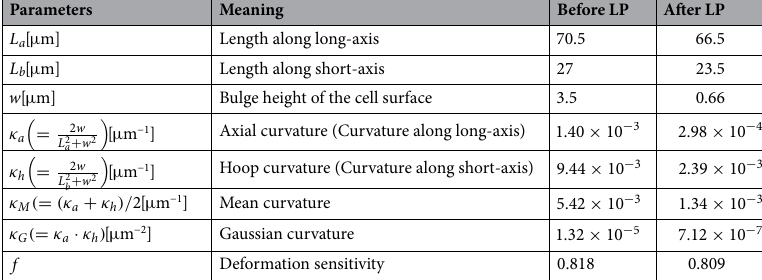
Table 1. Geometrical parameters of the onion epidermal cell in Fig.